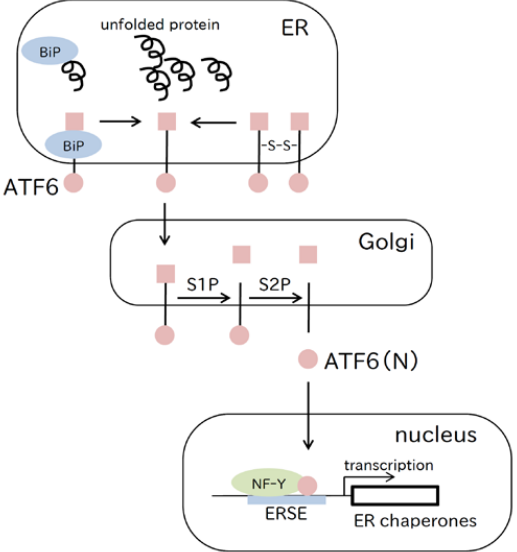
Figure 2. The ATF6 pathway. ATF6 detects unfolded proteins in the ER, and translocates to the Golgi apparatus. In the Golgi, ATF6 is cleaved by site 1 protease (S1P) and site 2 protease (S2P), and the N-terminal portion, ATF6(N), is translocated to the nucleus. ATF6(N) binds to the ERSE forming a heterodimer with NF-Y and enhances transcription of ER chaperone genes.